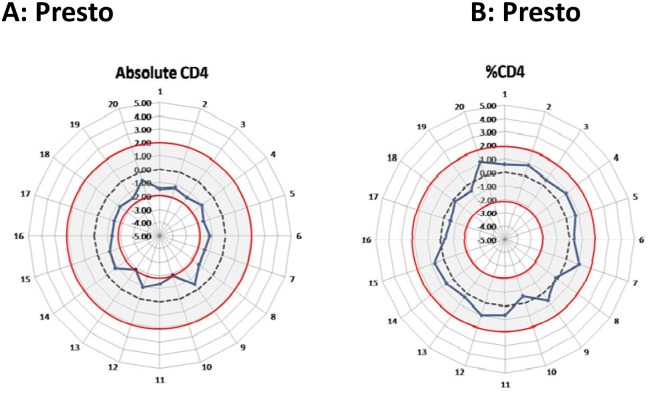
FACSPresto™ performance with EQA material.NHLS external quality assessment (EQA) scheme samples (n = 20) was analysed on the FACSPresto™ and SDI values (dark solid line) calculated for (a) absolute CD4 counts and (b) CD4% of lymphocytes. C and D indicate the corresponding performance of PLG/CD4 on the MPL system used as the predicate method in this study. The radar graphs depict the optimal target of zero (dashed line) and the acceptable range of -2 to 2 SDI (red circles with grey shaded area).